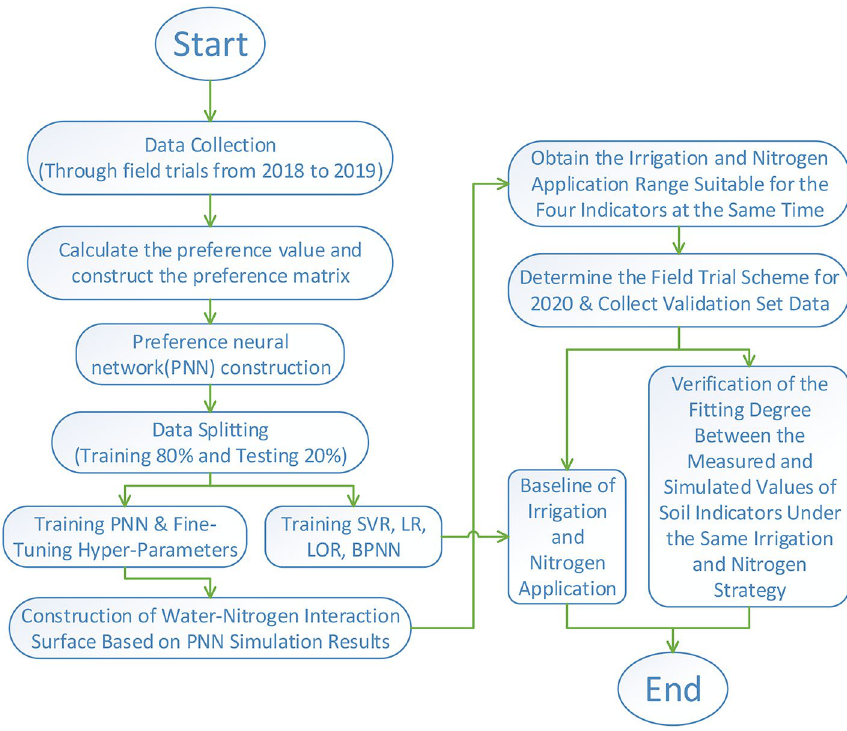
Figure 1. Flow chart of the proposed methodology to forecast evaporation using machine learning models.